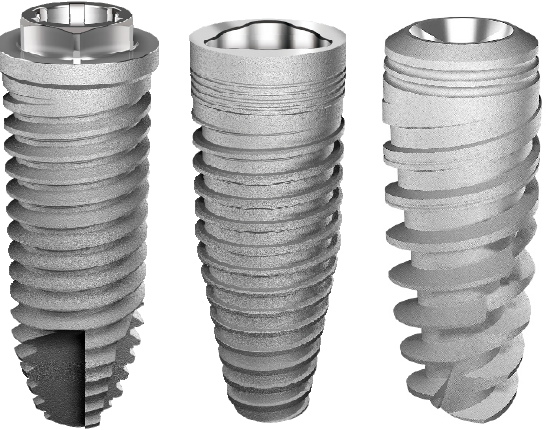
Figure 1. Representative image of the titanium implant macrogeometry used.